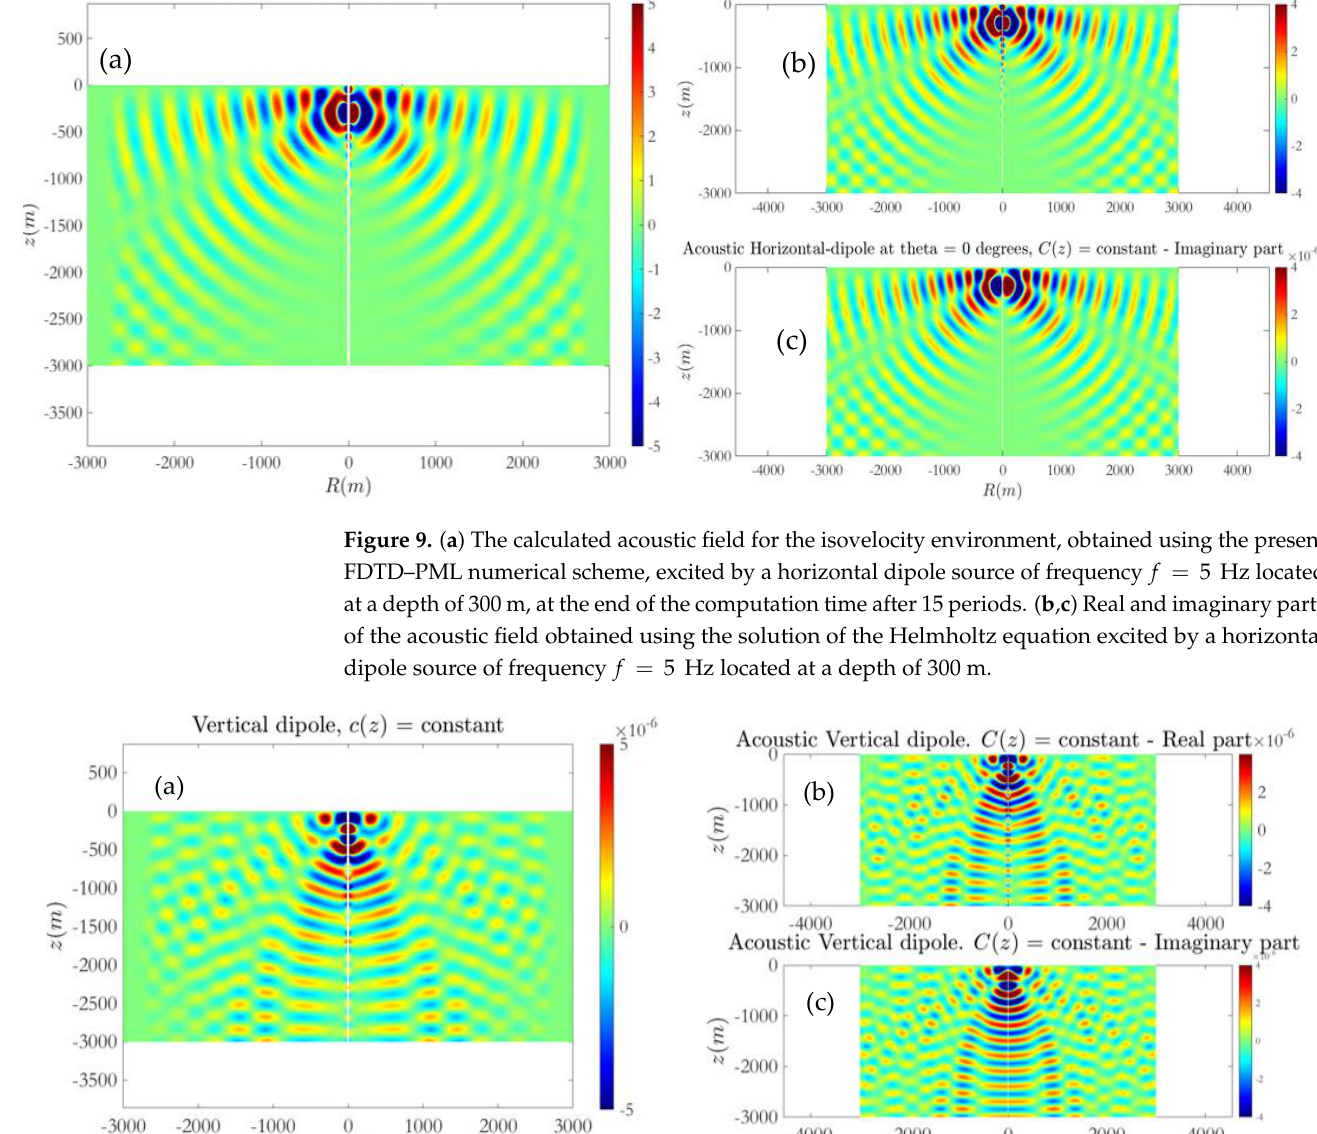
14 of 23 Figure 8. ( a ) The calculated acoustic field for the isovelocity environment, obtained using the present